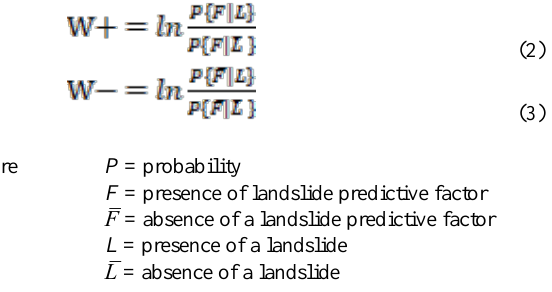
positive weight W + (Eq. 2) and negative weight W - (Eq. 3). ( W + indicates the presence of spatial association, and W - shows the absence of spatial relationship. The magnitude of the weight W suggests the level of spatial association. The evidence map is converted to a binary predictor map of presence and